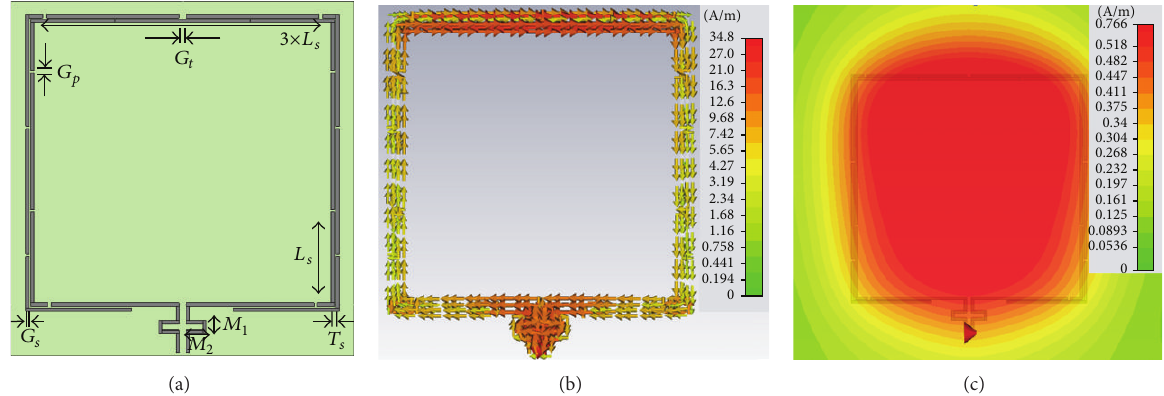
Figure 2: (a) Segmented loop antenna for animal tracking system. (b) Current distribution of the segmented loop antenna. (c) Magnetic field distribution of the segmented loop antenna for animal tacking system at 2.5 centimeters of distance.